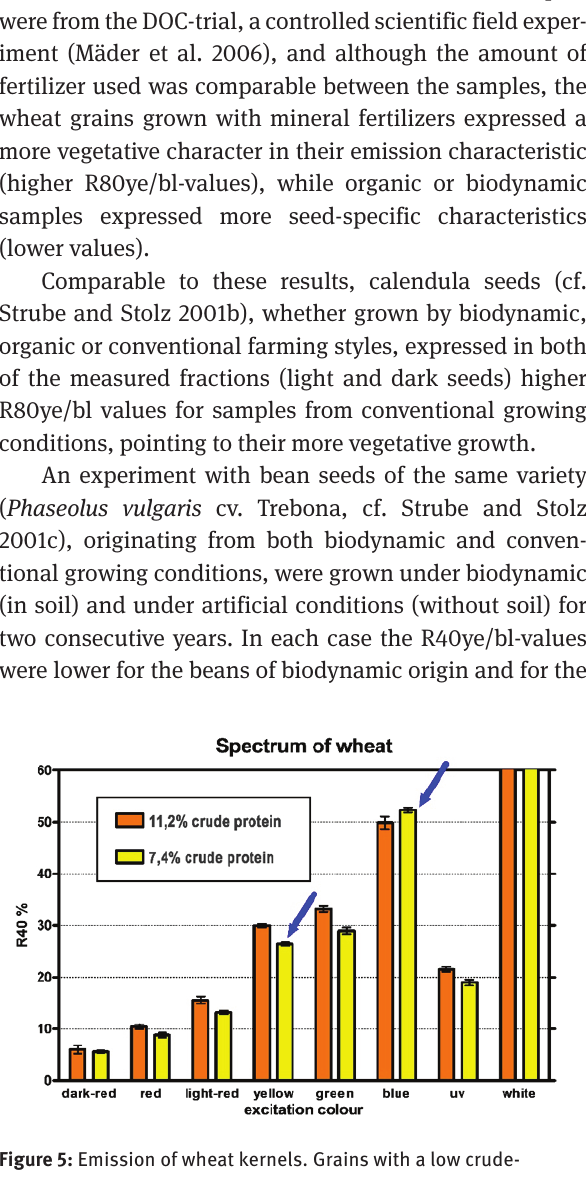
Figure 5: Emission of wheat kernels. Grains with a low crude- protein concentration showed a seed-typical spectral emission with a higher blue- and a lower yellow-induced emission intensity, compared to the grains with a high crude-protein concentration (unpublished data)